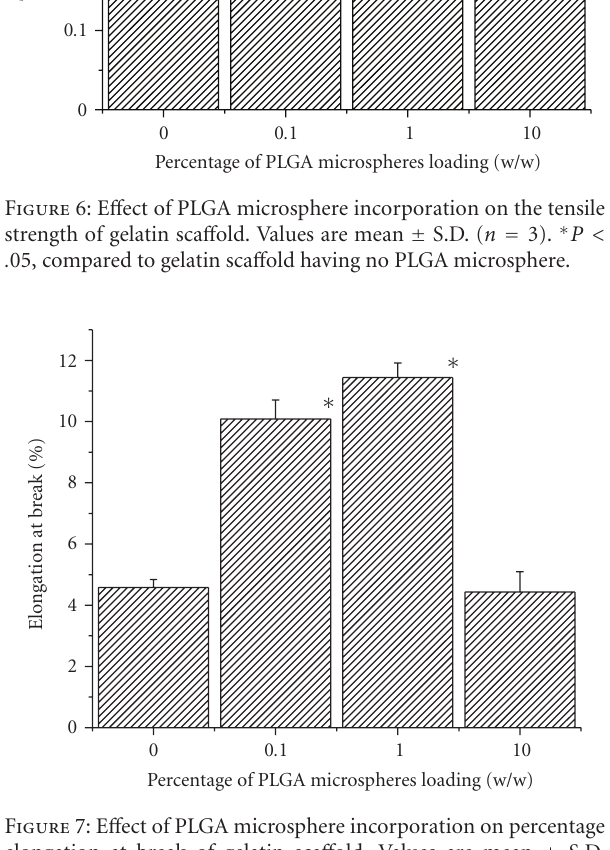
Figure 5: E ff ect of PLGA microsphere incorporation on sca ff old porosity. Values are mean ± S.D. ( n = 3). ∗ P < . 05, compared to gelatin sca ff old having no PLGA microsphere.